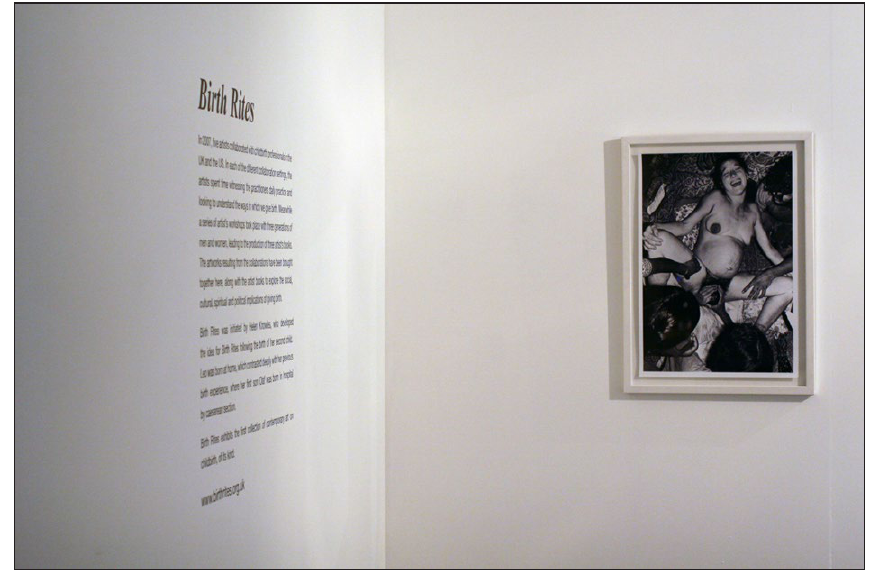
Figure 23: Installation view of Terese Crowning in Ecstatic Childbirth at Glasgow Sci- ence Centre by Hermione Wiltshire, 2008 (Birth Rites